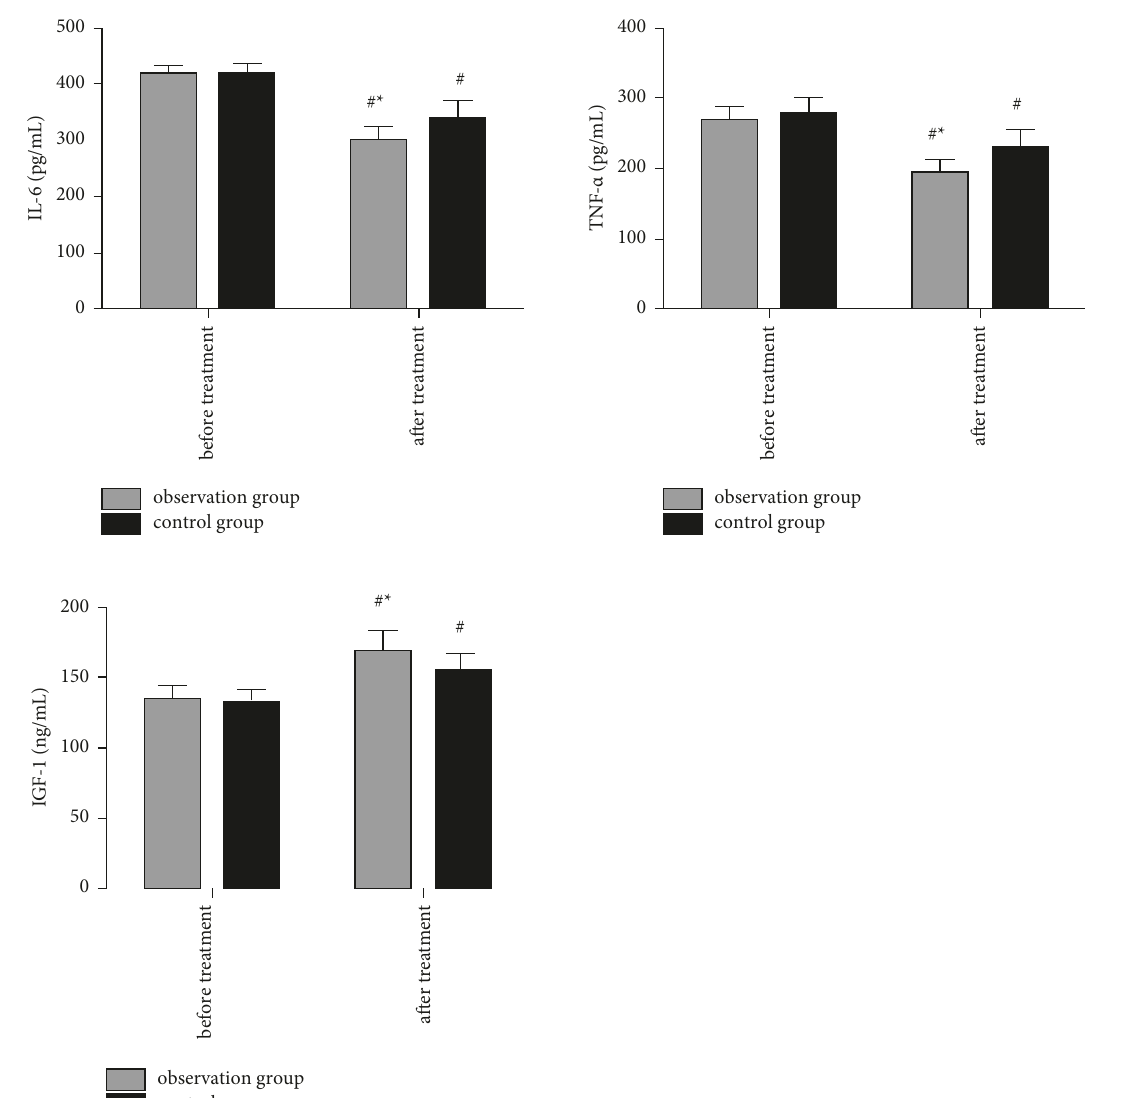
Figure 4: The comparison of cytokines in groups with/without prebiotics/probiotics preparations ( # P < 0 . 05 represents comparing with the same group before treatment; ∗ P < 0 . 05 represents comparing with the control